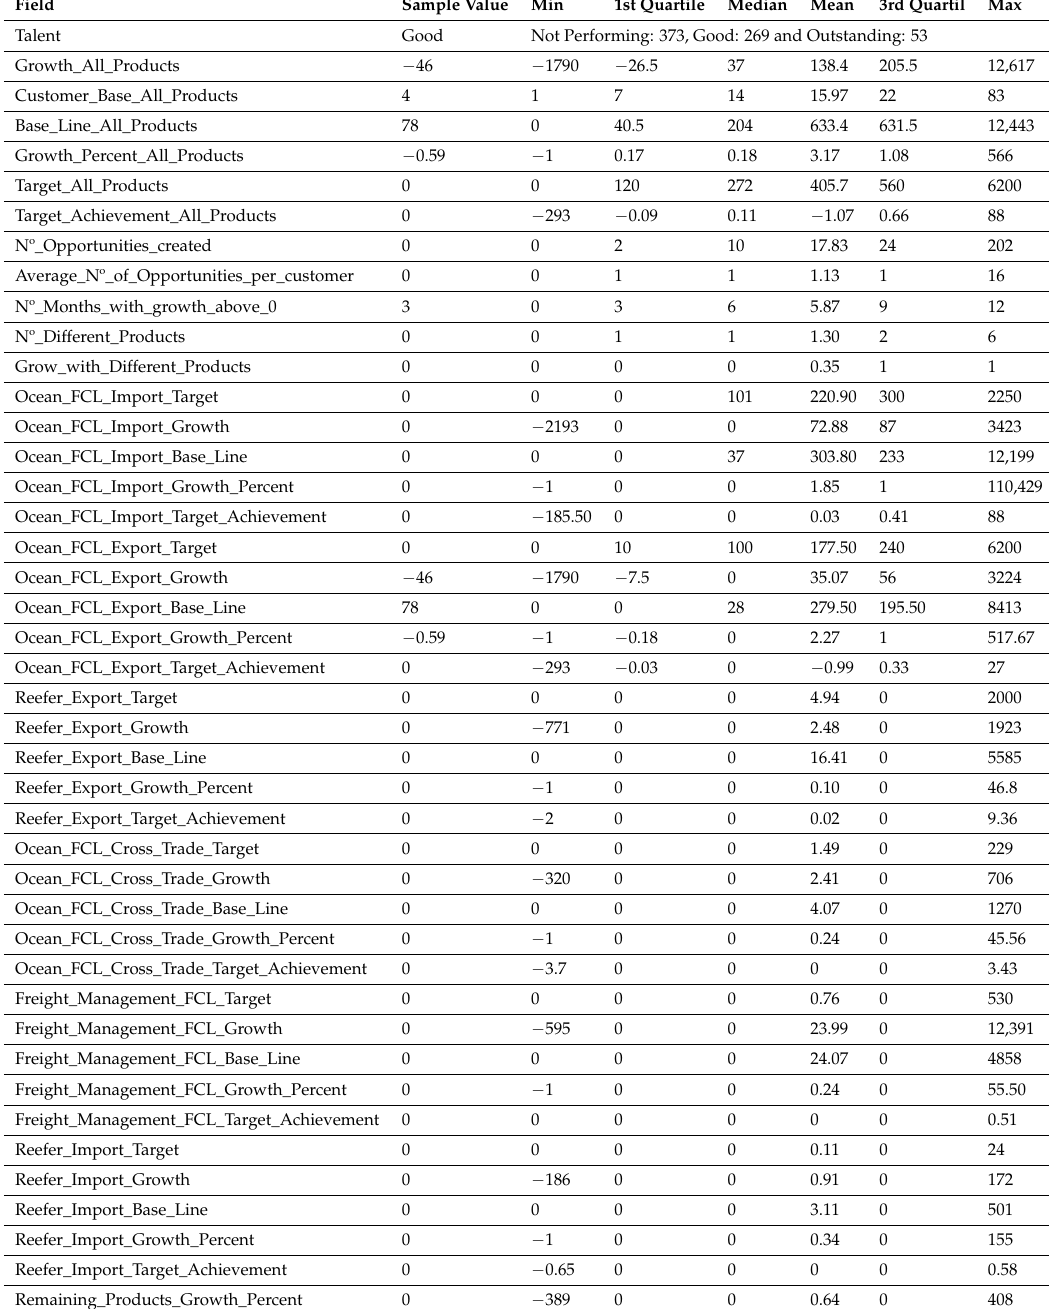
Table 3. Table with classification